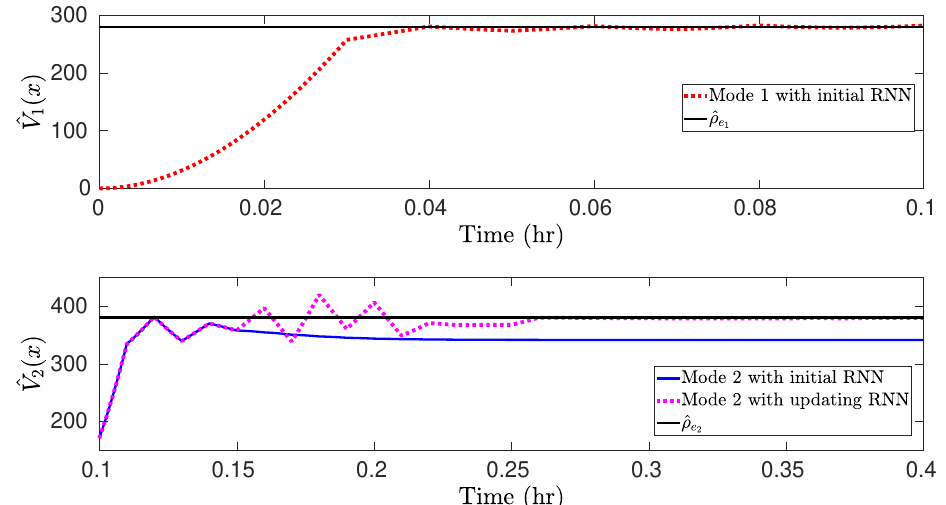
Figure 6. Comparisons of ˆ V 1 ( x ) for mode 1 using the initial offline-learning RNN (red dashed line), and ˆ V 2 ( x ) for mode 2 using the initial RNN (blue solid line) and online updating RNNs (pink dashed